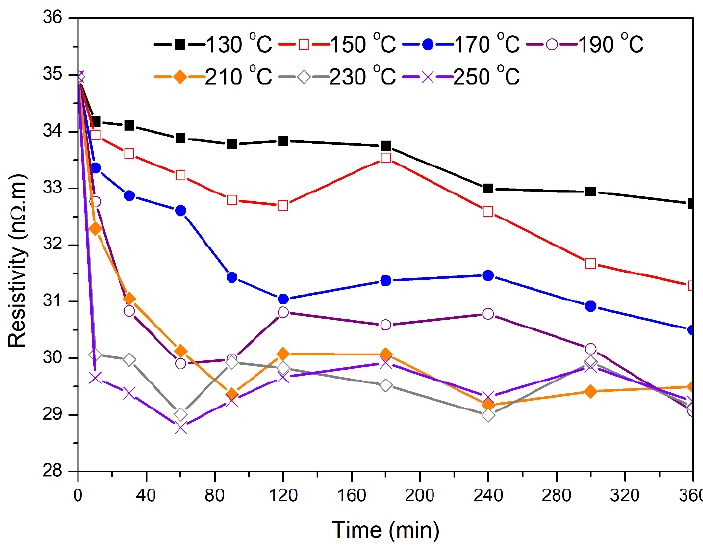
Figure 4. Changes in electrical resistivity as a function of the annealing time for 1.7 mm samples at the specified temperature.